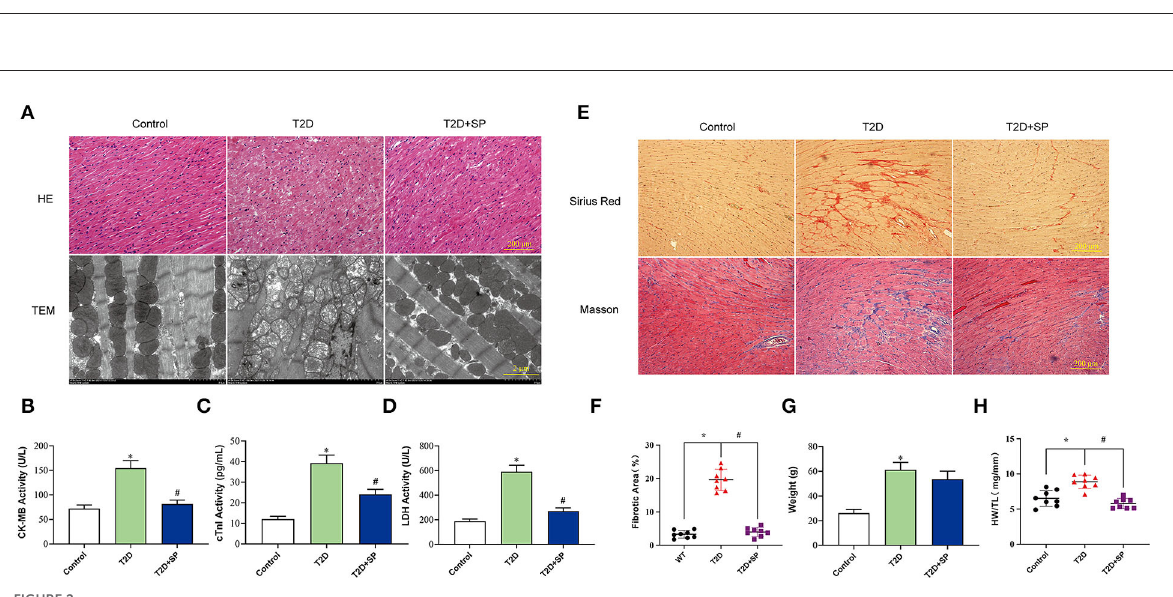
FIGURE2 SP ameliorates diabetic cardiomyopathy by protecting myocardial tissue and reducing collagen depositions. (A) Representative images of H&E staining and transmission electron microscopy, (B) serum CK-MB concentration, (C) serum cTnI concentration, (D) serum lactate dehydrogenase concentration, (E) representative Sirius red staining and Masson’s trichrome of cross sections of heart tissues, (F) fibrotic area statistics of cardiac tissue, (G) body weight, and (H) the ratio of heart weight to tibia length. * P < 0.05 vs. Control group; # P < 0.05 vs . T2D group ( n =